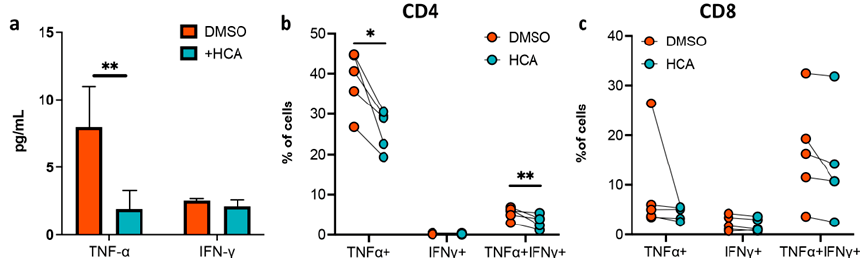
Figure 10. HCA suppresses the inflammatory response in PBMCs isolated from CD patients. ( a ) TNF- α and IFN- γ production was measured via ELISA and compared between HCA- and DMSO-treated PBMCs (isolated from seven CD patients) after stimulation with CD3/CD28-coated magnetic beads. Proportions of TNF- α + and IFN- γ + subsets in ( b ) CD4+ and ( c ) CD8+ T cells measured by flow cytometry. The paired samples t -test was used to compare the two groups. * p < 0.015; ** p < 0.01. CD, Crohn’s disease; PBMCs, peripheral blood mononuclear cells; TNF- α , tumor necrosis factor- α ; IFN- γ , interferon- γ .